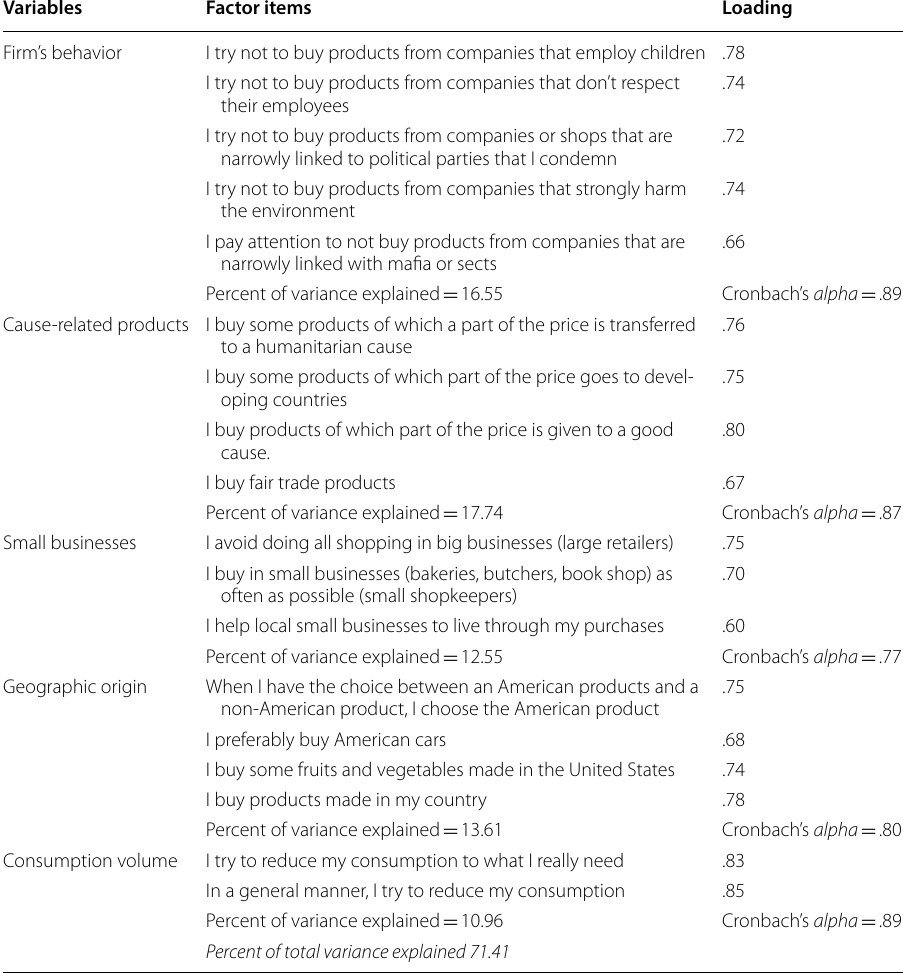
Table 1 Factor analysis results for socially consumption behavior Variables